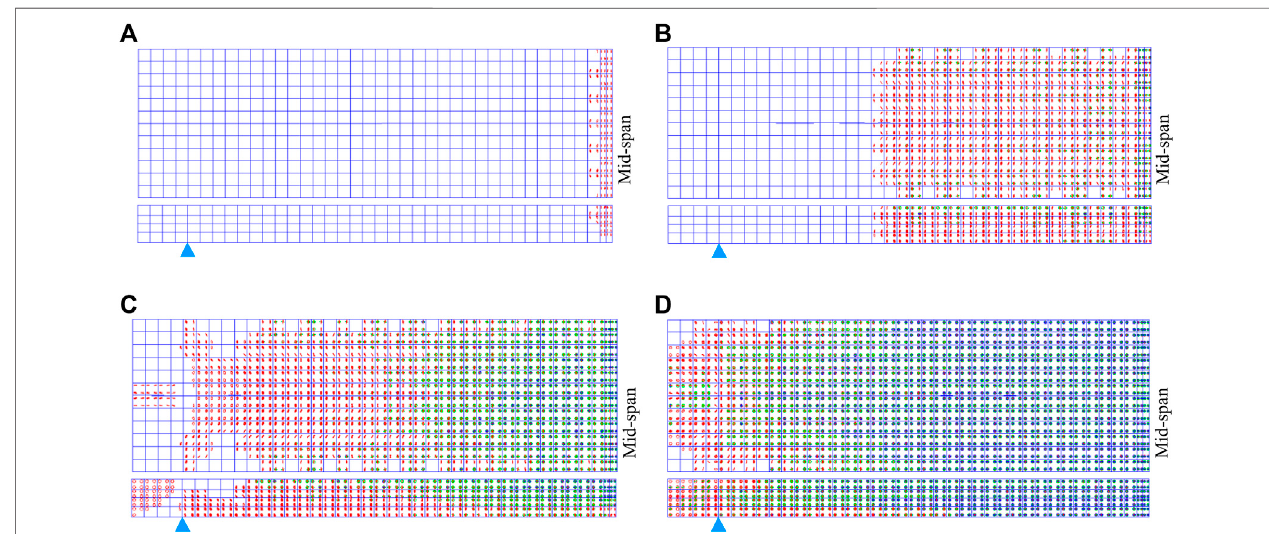
FIGURE10| Simulationofcrackpropagationoftheconcreteslabunderdifferentloadlevels: (A) loadtothe F cr ; (B) loadtothe25% F u ; (C) loadtothe40% F u ;and (D) load to the F u .